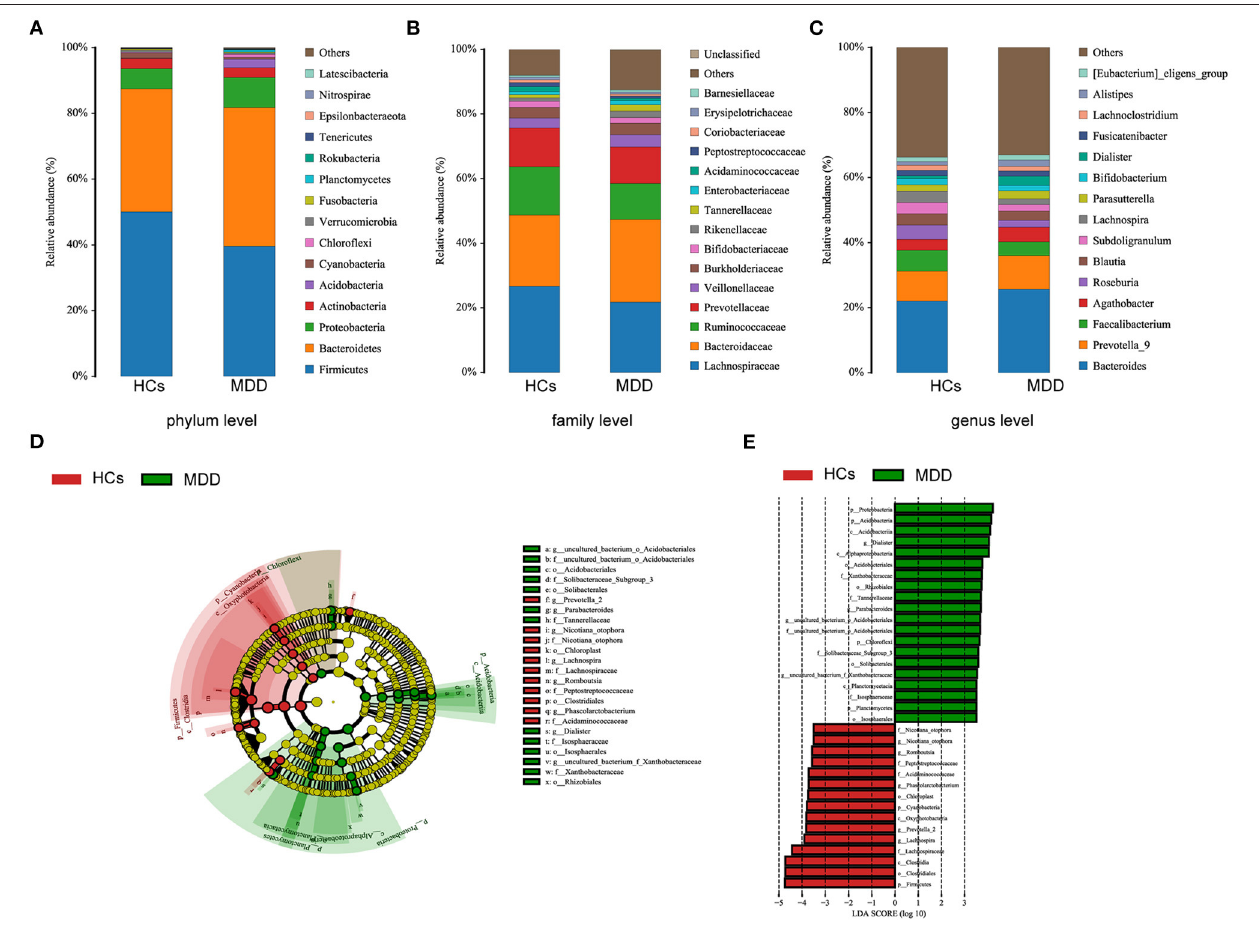
FIGURE 3 | Taxonomic differences in fecal microbiota between HCs and MDD patients. Comparison of relative abundance at the bacterial phylum (A) , family (B) and genus (C) levels between HCs and MDD patients. LEfSe identified the most differentially abundant taxa between HCs and MDD patients. The brightness of each dot is proportional to its effect size (D) . Taxa enriched in HCs are indicated with a negative logarithmic discriminant analysis (LDA) score (red), and taxa enriched in MDD patients have a positive score (green). Only taxa meeting an LDA significance threshold > 3.5 are shown (E)